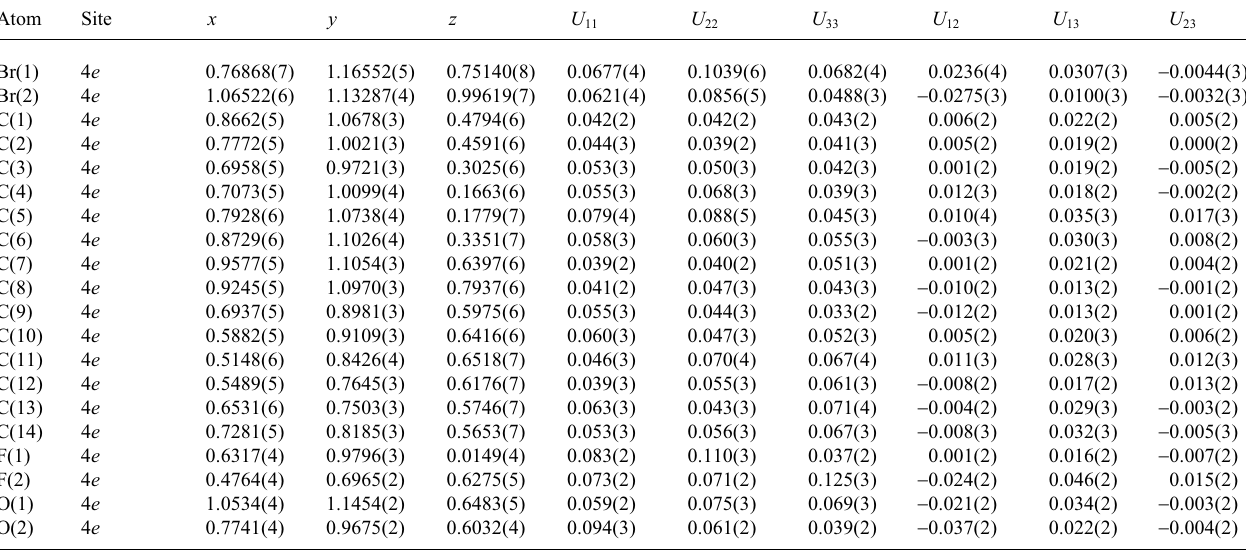
Table 3. Atomic coordinates and displacement parameters (in Å 2 )